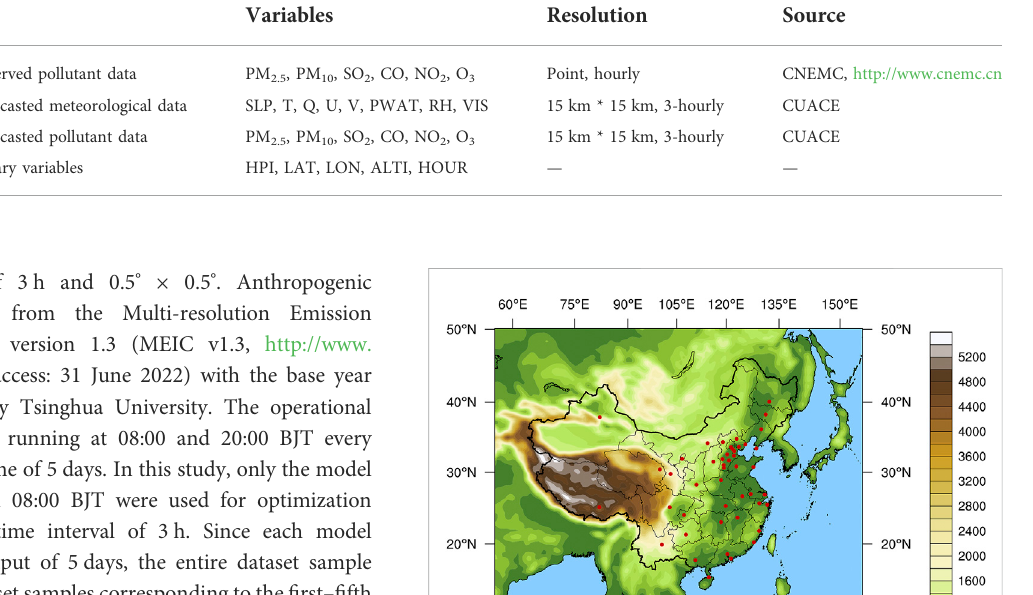
TABLE 1 Summary of the knowledge base. Num.